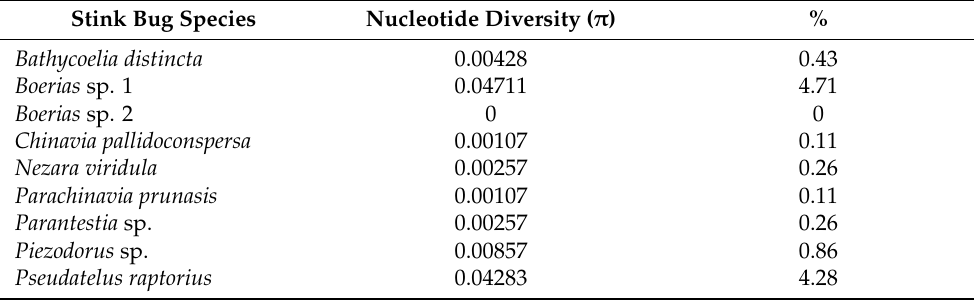
Table 1. Nucleotide diversity ( π ) values for nine of the stink bug species from this study. Stink Bug Species Nucleotide Diversity ( π